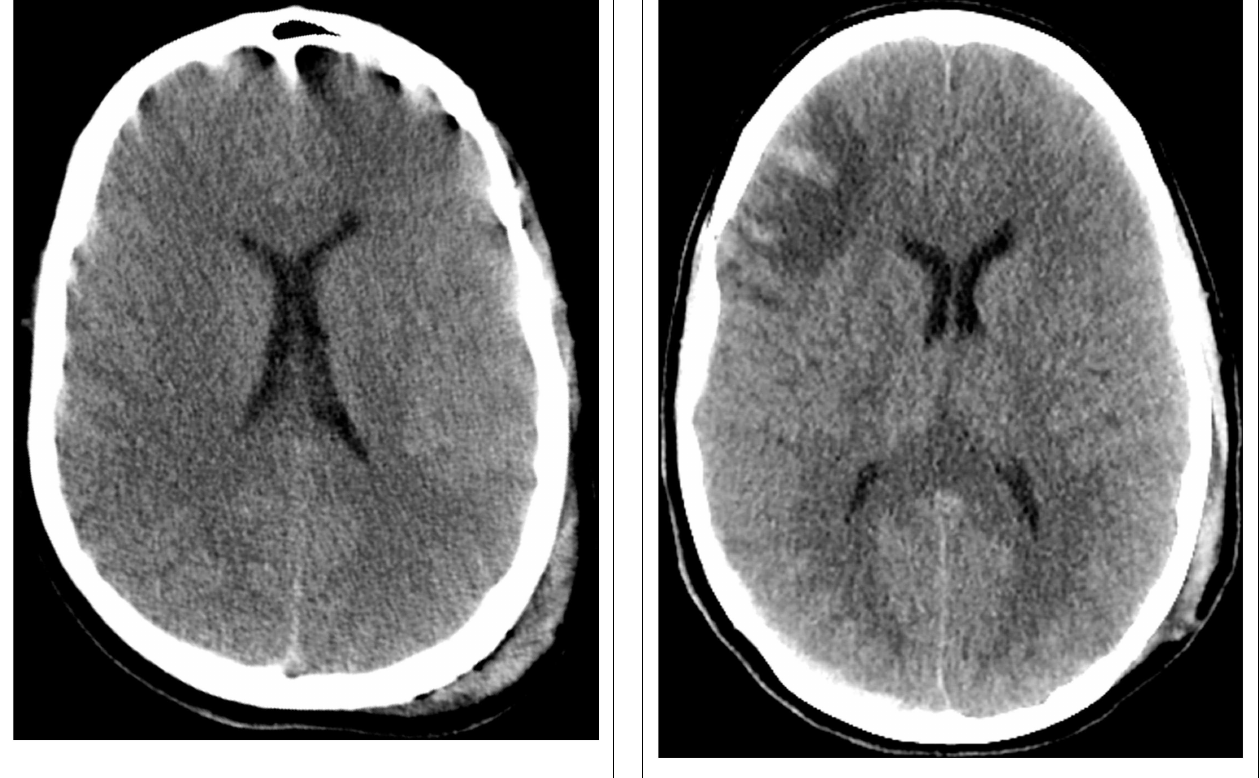
FIGURE 2 | CT scan of the head on hospital day 11 demonstrates expected evolution of the previously noted cortical contusions, subdural hematomas, and changes of diffuse axonal injury. No new hemorrhage, mass effect, hydrocephalus, or CT radiographic evidence